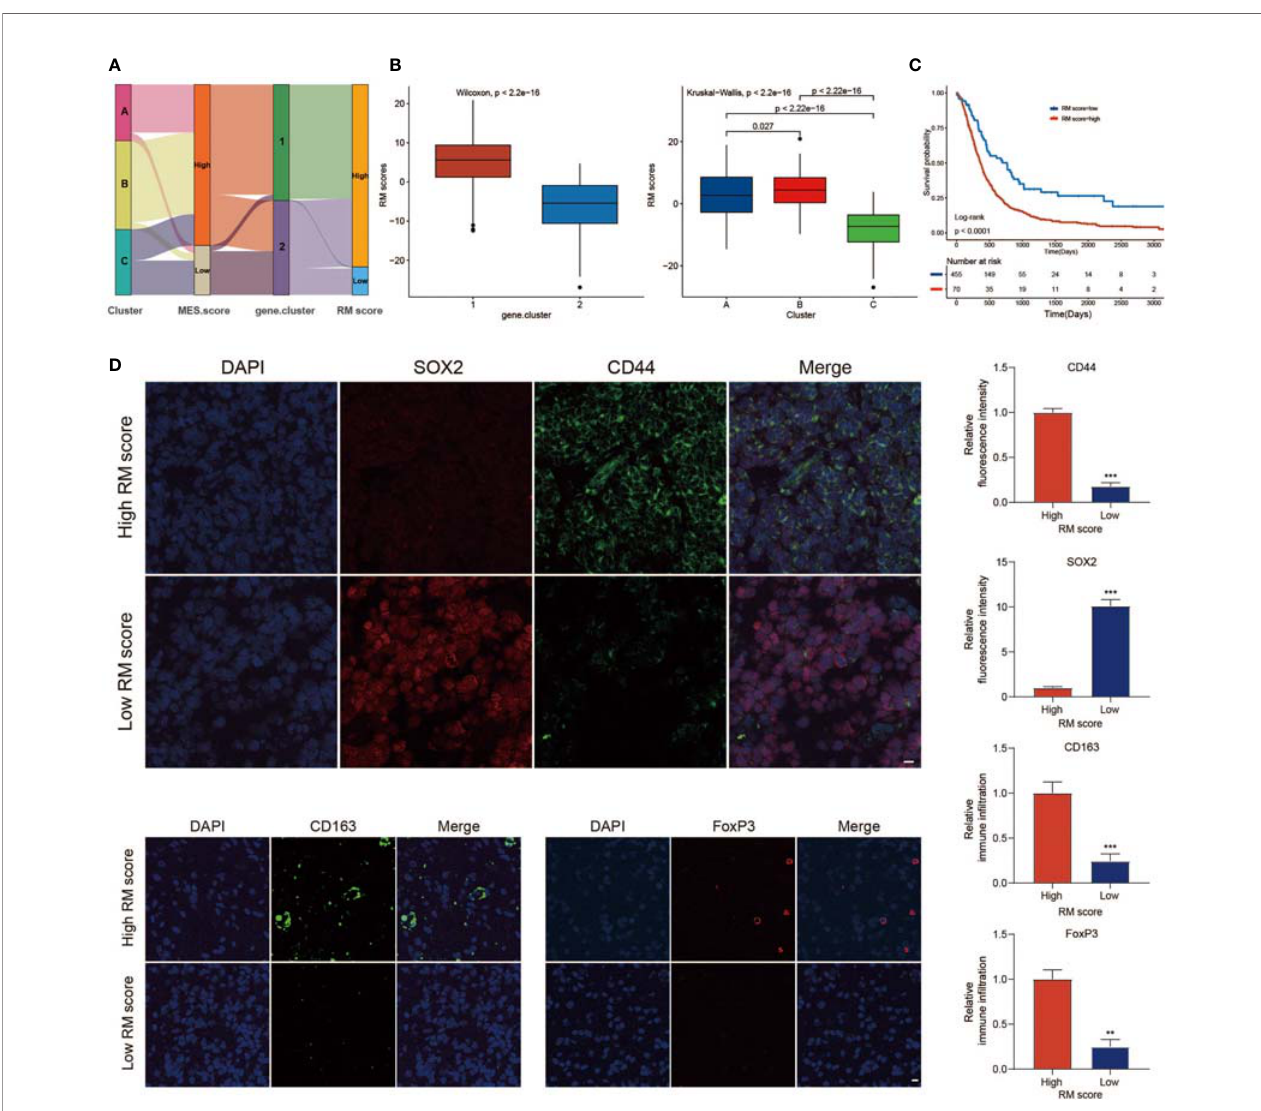
FIGURE 6 | Calculation of regulator score (RM) score. (A) Sankey plot showing the changes in non-m 6 A RNA modi fi cation patterns, MES scores, gene.clusters, and RM scores. (B) Differences in RM scores among the two gene.clusters and three non-m 6 A RNA modi fi cation patterns. (C) Survival analyses for the high RM score and low RM score patient groups. (D) IF staining in GBM tissues showed the expression of CD44, SOX2, CD163, and FoxP3. Histogram representing relative fl uorescence intensity (scale bar = 15 m m). ** means P<0.01; *** means